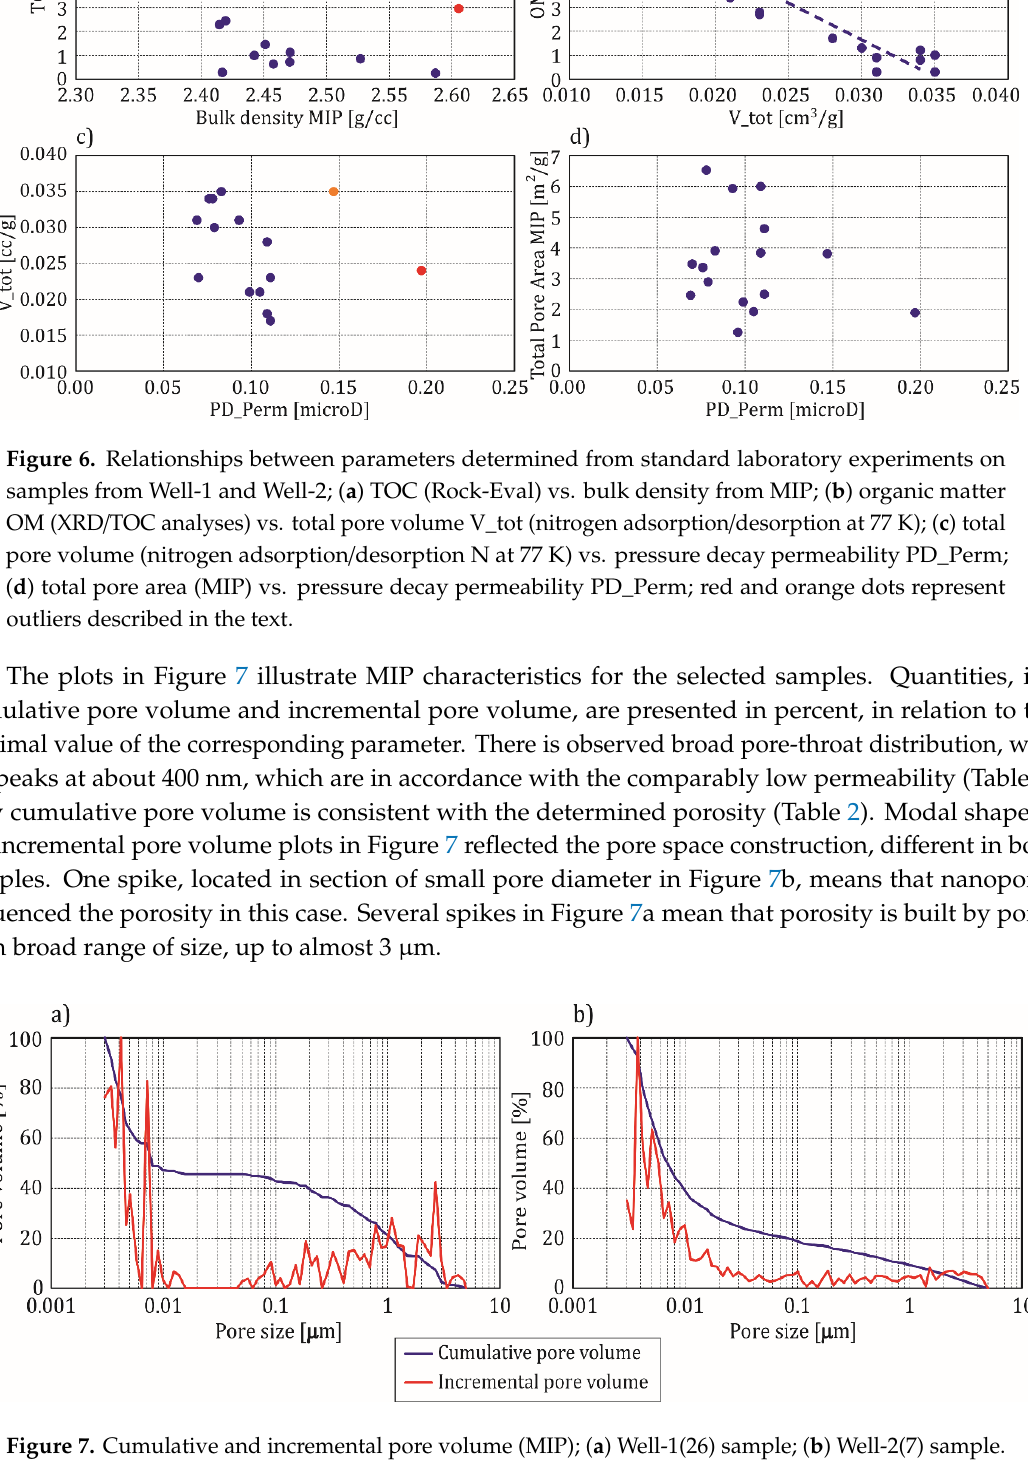
Figure 7. Cumulative and incremental pore volume (MIP); ( a ) Well-1(26) sample; ( b ) Well-2(7) sample.